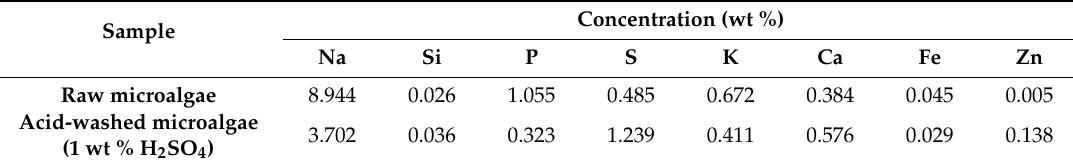
Table 1. XRF analysis of microalgae after chemical